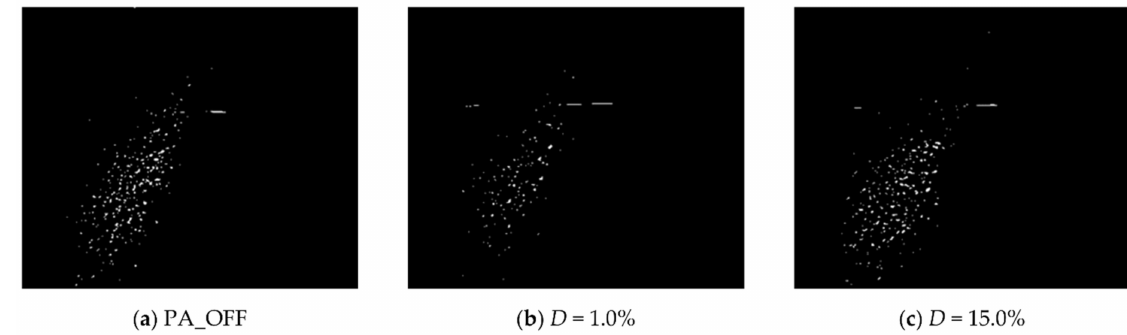
Figure 31. Snow accumulation test (arc model) [Result_1].